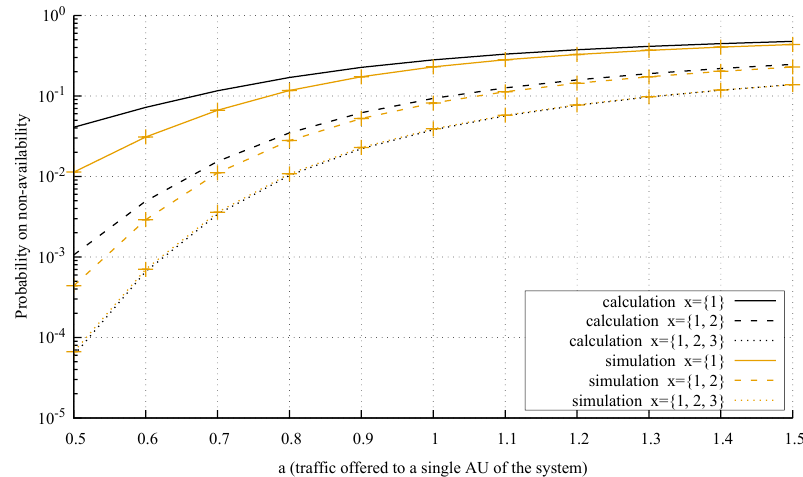
Figure 1. Probability of the non-availability of x strictly determined resources for class 1 calls ( t 1 = 1) in System 1, where x is the set of strictly determined resources in the limited-availability group.